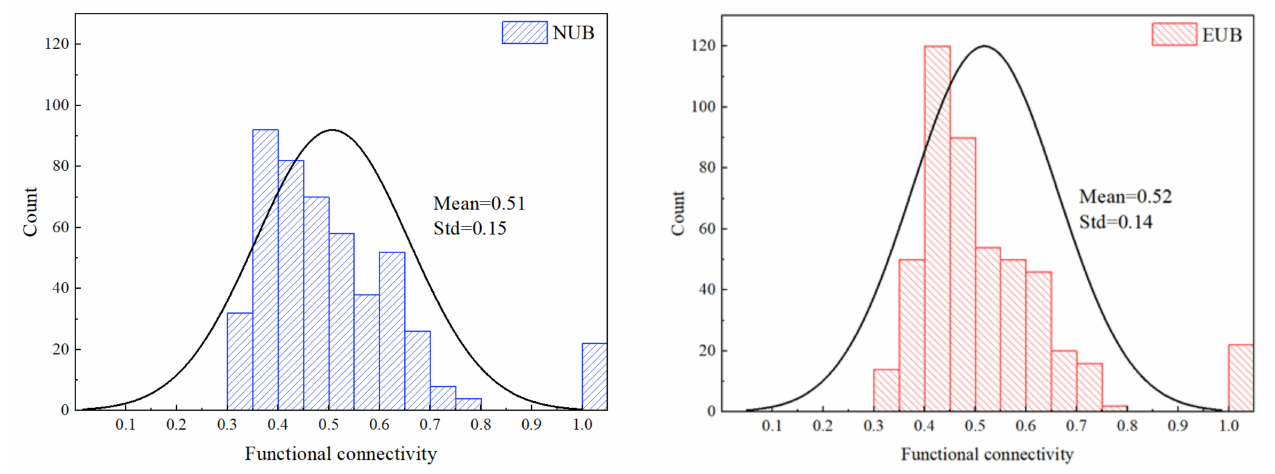
Figure 4. Histograms of the functional connectivity distribution of NUB and